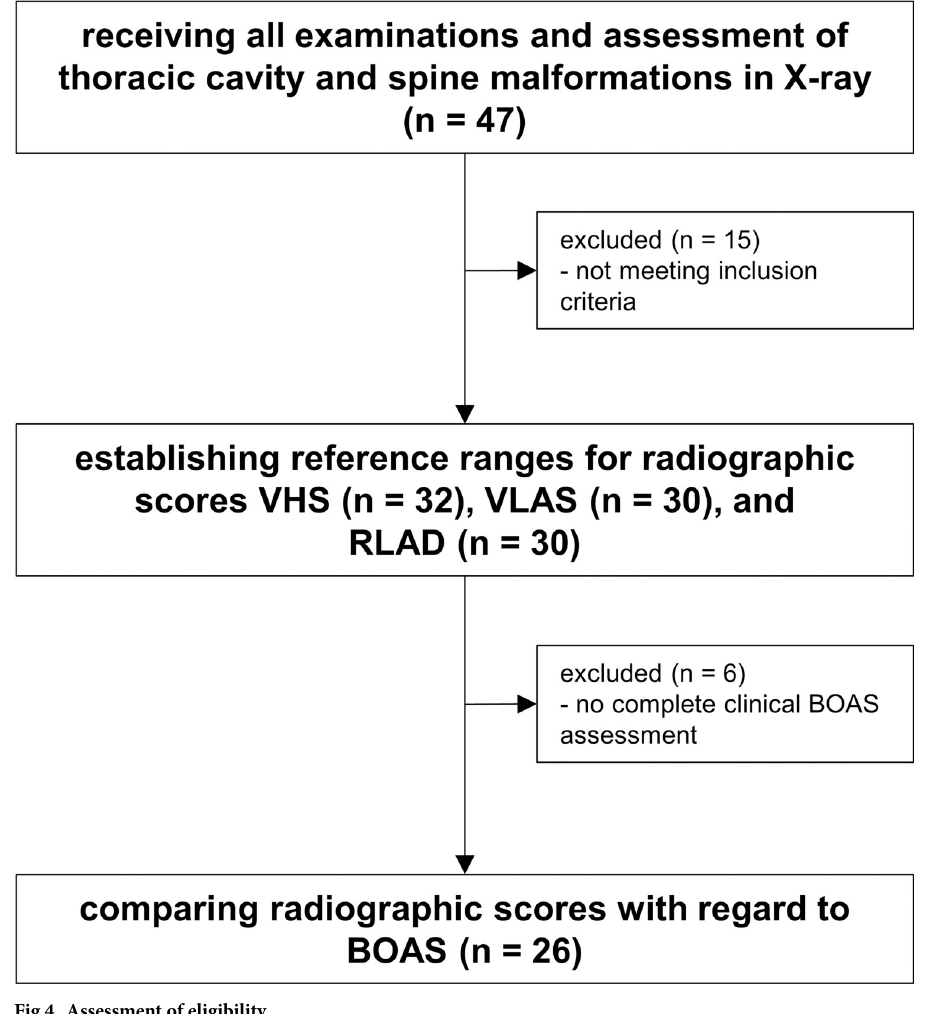
Fig 4. Assessment of